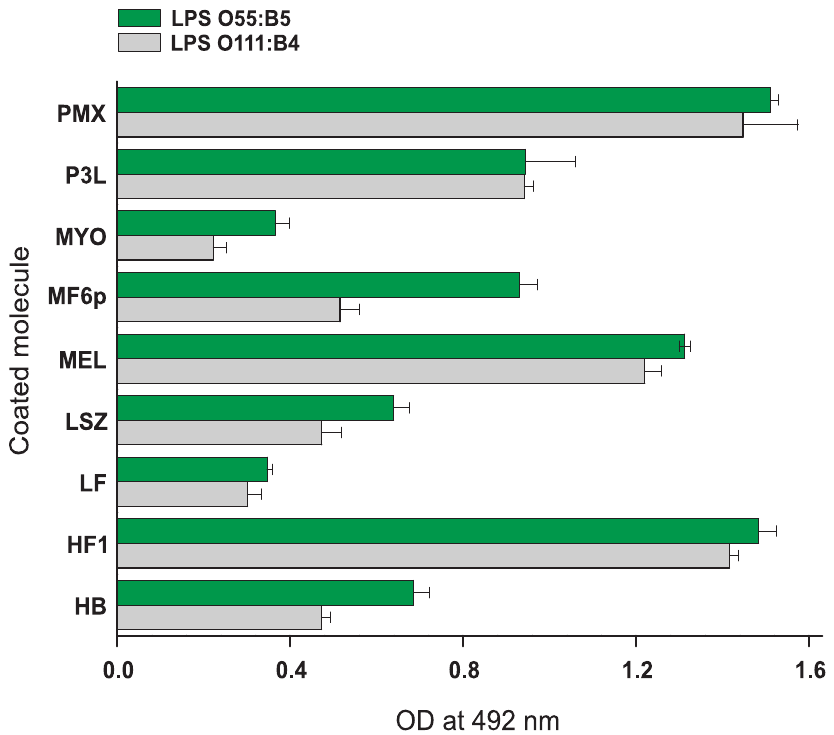
Fig 3. LPS binding in indirect ELISA. FITC-LPSs from E . coli serotypes O111:B4 (1.25 μ g/ml) and O55:B5 (2.5 μ g/ml), diluted in PBS-EDTA with 0.05% Triton X-100, were added to plates coated with several proteins and peptides (1 μ g/well) and blocked with BSA. Data represent the mean values ± SD of duplicate samples. HB, hemoglobin; HF1, histone f1 fraction; LF, lactoferrin; LSZ, lysozyme; MEL, melittin; MF6p, synthetic FhHDM-1/MF6p; MYO, myoglobin; P3L, A . simplex peptide: MCQCVQKYGTEFCKKRLA; PMX, polymyxin B; BSA, bovine serum albumin.